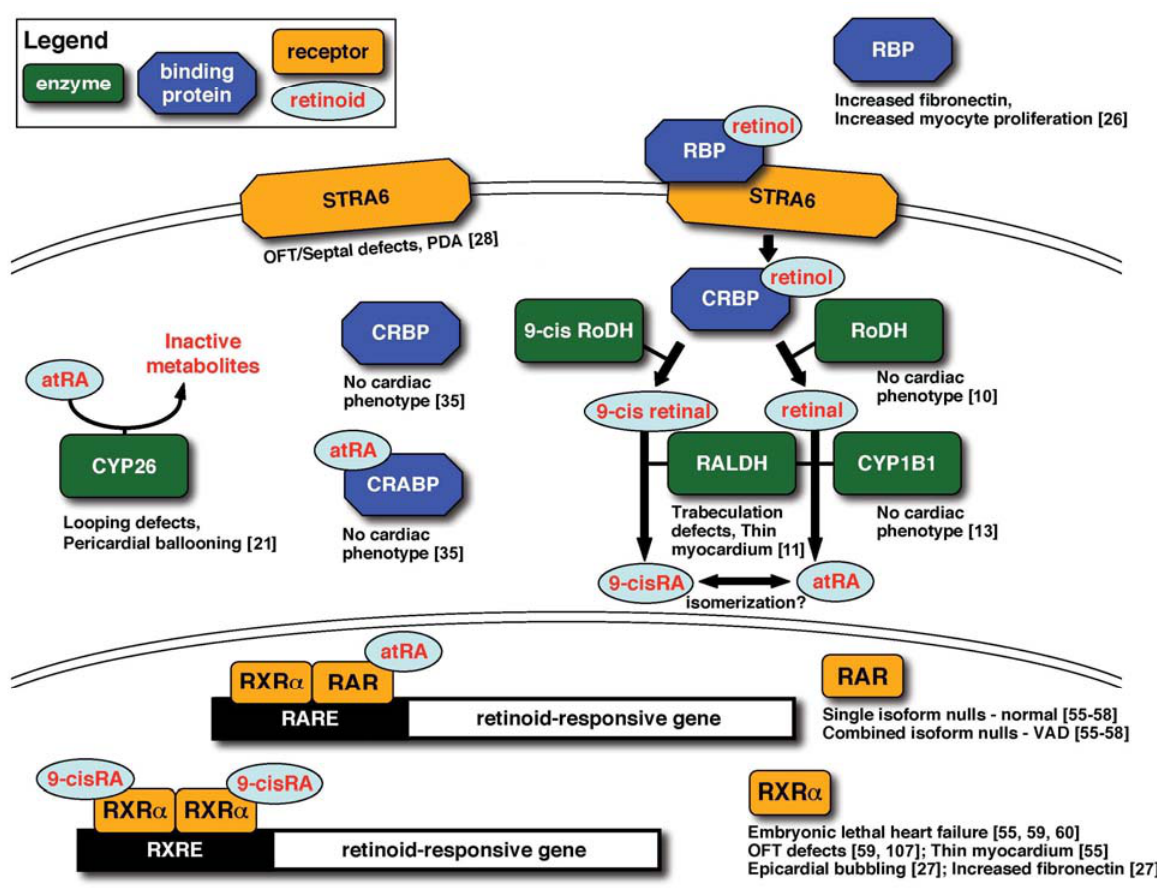
FIGURE 1. Retinoid signaling and associated cardiac phenotypes in mutant mice. Green signifies protein is an enzyme; blue, retinoid binding protein; orange, receptor; red font, retinoid. See text for pathway details. Where knockout mice have been generated, a brief description of the phenotype is provided adjacent to the protein along with the appropriate references. No description is given if a knockout has not been reported to date. CYP1B1, cytochrome P450 1B1; CYP26, cytochrome P450 26; RALDH, retinaldehyde dehydrogenase; RoDH, retinol dehydrogenase, 9- cis RoDH, 9- cis retinol dehydrogenase; RBP, retinol binding protein; CRBP, cellular retinol binding protein; CRABP, cellular retinoic acid binding protein; STRA6, retinol binding protein receptor; RXR α , retinoid X receptor alpha; RAR, retinoic acid receptor; atRA, all- trans retinoic acid; 9- cis RA, 9- cis retinoic acid; RXRE, retinoid X response element; RARE, retinoic acid response element; OFT, outflow tract; PDA, patent ductus arteriosus; VAD, Vitamin A Deficiency